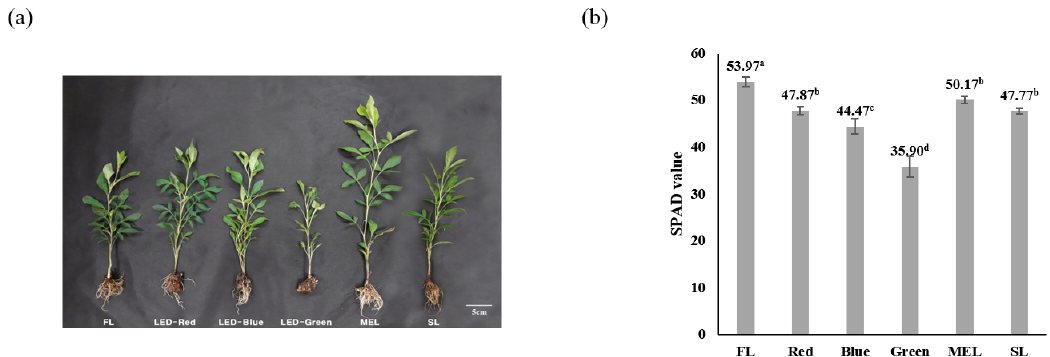
Figure 1. Growth characteristics ( a ) and chlorophyll contents ( b ) of Dachul under different light sources. Values represent mean of data obtained from three independent experiments ( p < 0.05).